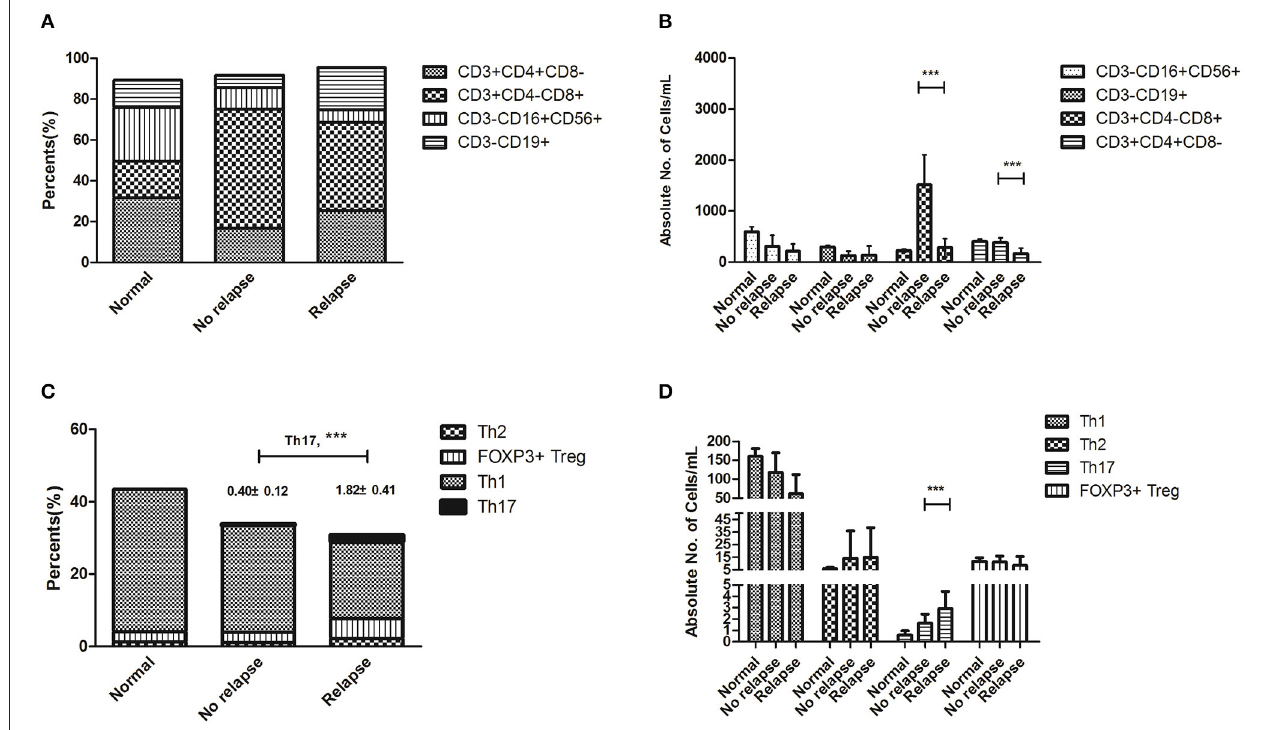
FIGURE 1 | Immune status at the onset of relapse after hematopoietic stem cell transplantation (HSCT) compared with that of patients remaining at remission. Statistical differences are marked by the P -values. (A) The percentages showed no statistical differences in CTL, T helper, NK, and Treg cells. (B) It showed significantly decreased absolute counts of CD3 + CD4 − CD8 + T cells (281.2 ± 174.1 vs. 1514.5 ± 576.6, P < 0.001) and CD3 + CD4 + CD8 − T cells (172.7 ± 100.7 vs. 389.7 ± 82.5, P < 0.001) in patients with relapse after HSCT. (C) There was a significant increase in the percentages of Th17 cells (1.82 ± 0.41 vs. 0.40 ± 0.12, P < 0.001) and no statistical differences in Th1, Th2, and FOXP3 + Treg cells. (D) There was a significant increase in the absolute count of Th17 cells (4.88 ± 2.46 vs. 1.50 ± 0.72, P = 0.001), while there were no statistical differences in Th1, Th2, and FOXP3 + Treg cells. *** P <